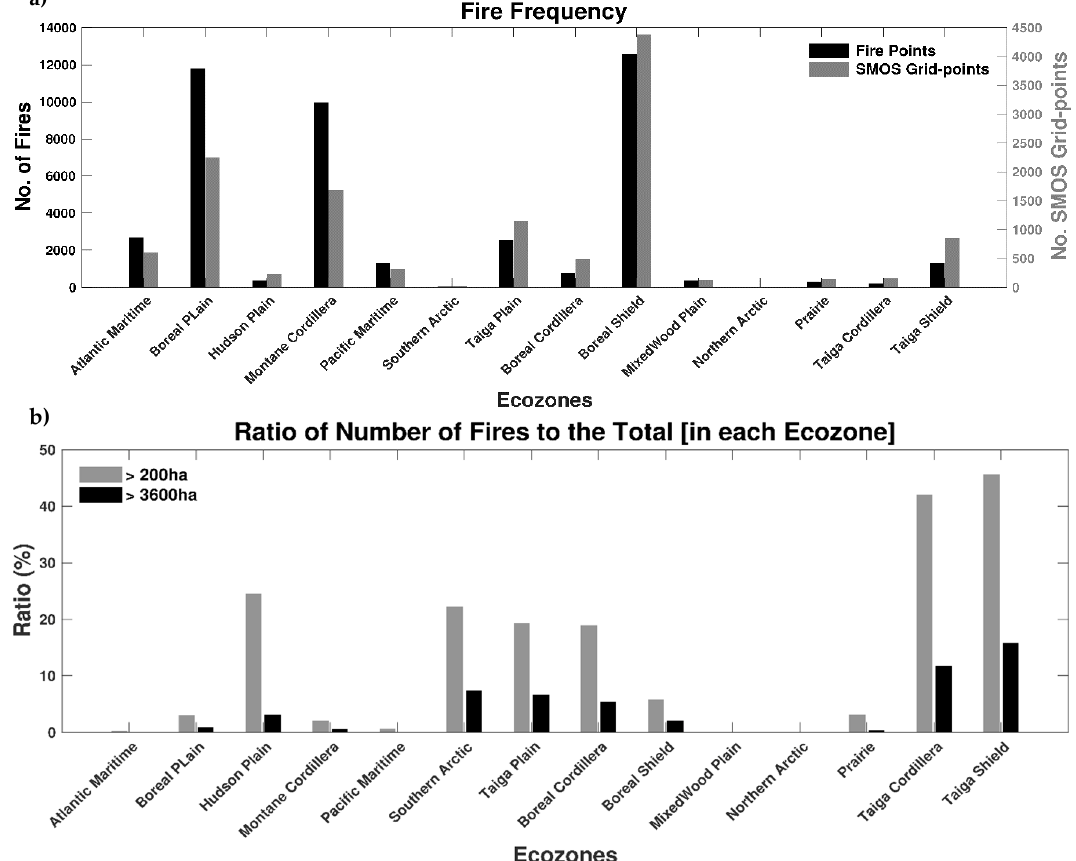
Figure 2. Frequency of all fires and the number of SMOS (Soil Moisture and Ocean Salinity) grid cells that are representative of the fires ( a ); ratio of the number of fires to the total ( b ).